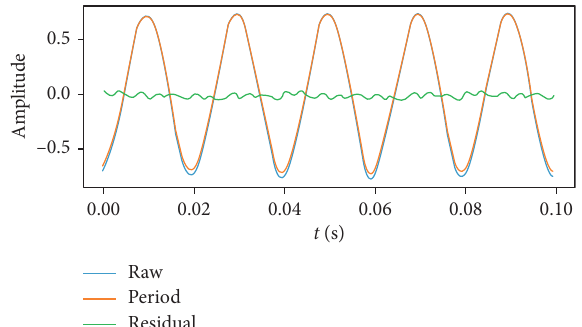
Figure 6: Comparison of the periodic signal with the residual signal and the original signal.